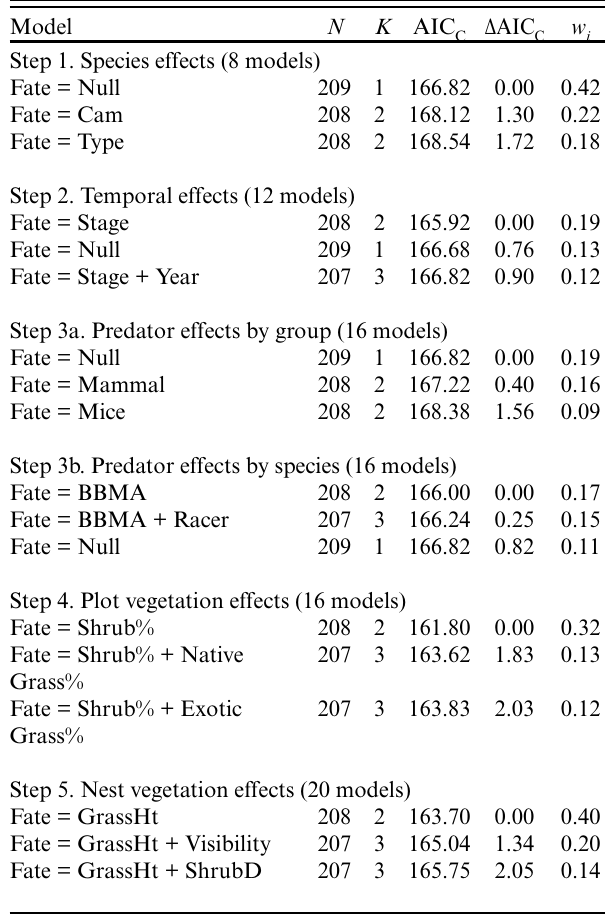
Table 3 . AIC ranking of logistic-exposure models for predation- C specific daily nest survival rate of songbirds nesting in sagebrush habitat. A multistep variable inclusions approach was used to minimize the number of variables in any given model. The top three models for each step are shown. See Table 1 for